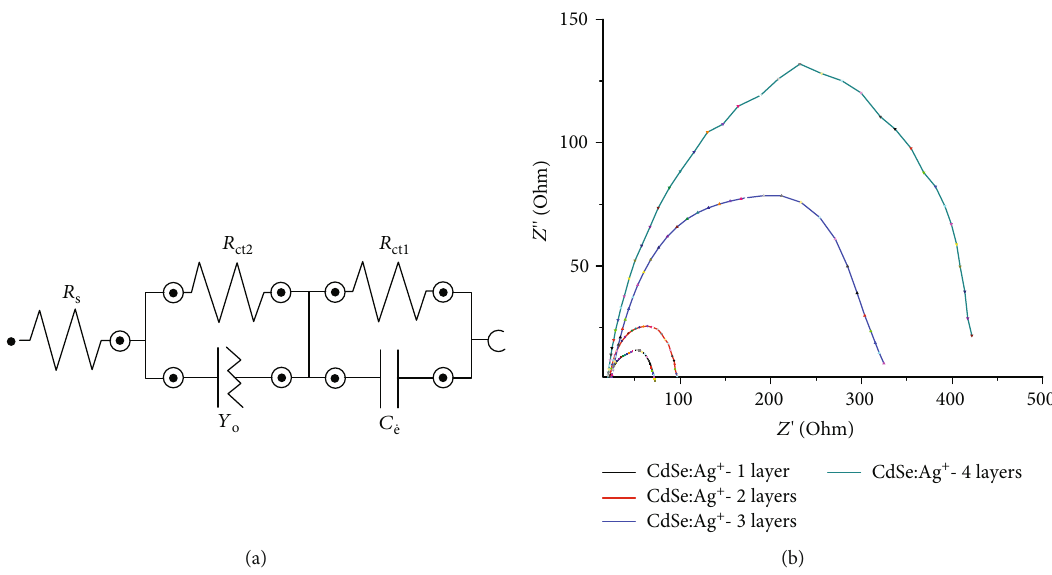
Figure 5: (a) The circuit diagram of devices and (b) Nyquist plots of QDSSCs with the di ff erent layers.